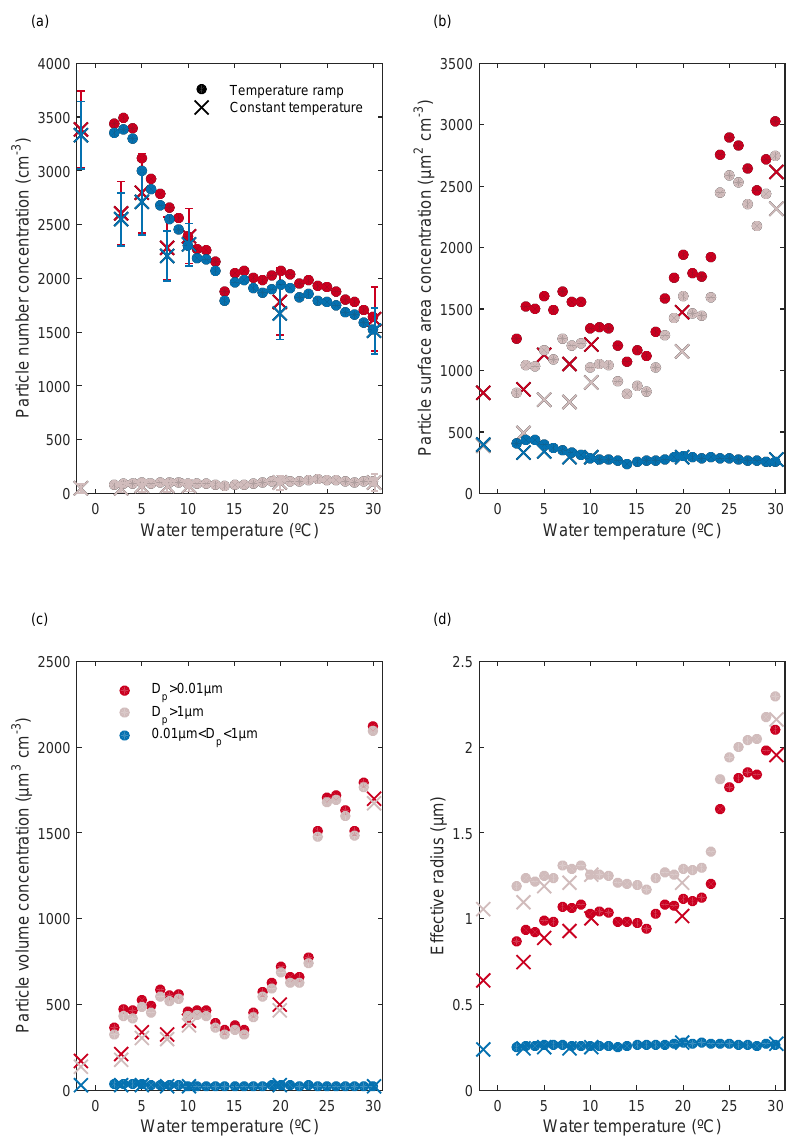
Figure 3. Integrated (a) number, (b) surface, and (c) volume as a function of water temperature for the constant water temperature experiments (crosses) and during the temperature ramp experiment (circles). One standard deviation (1 σ ) is shown for the integrated number concentration during the constant temperature experiments. Panel (d) plots the effective radius as a function of water temperature for all